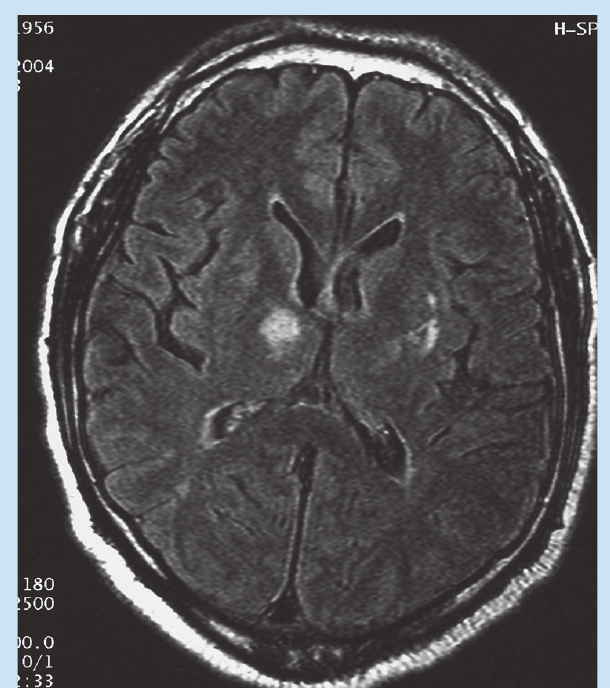
Fig. 1. Axial T2-weighted flair image shows high intensity lesions in thalami